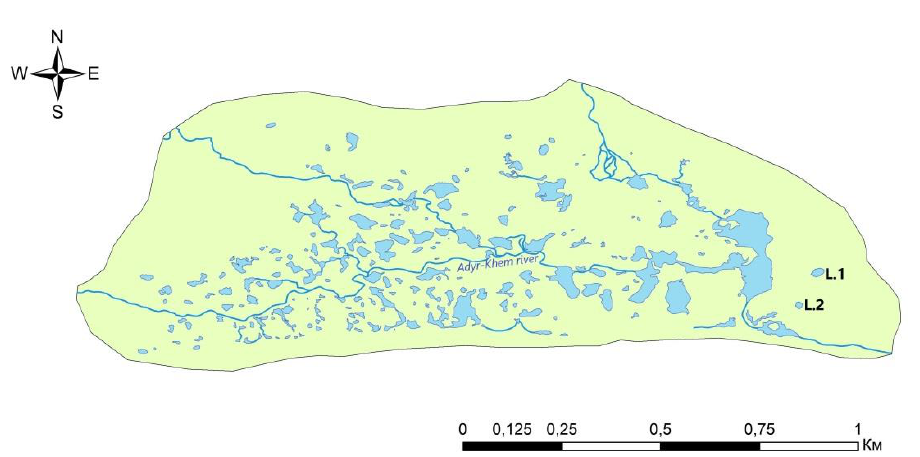
Figure 7. The open water bodies at the study site compiled for the reference date: 15 July 2021. Adyr- Khem river valley at Alash plateau; southern slope of the Western Sayan montane region, Republic of Tuva, Russia. The marks L.1 and L.2 refer to location of (untitled) thermokarst lakes studied in Section 3.3. An assessment based on interpretation of satellite imagery (Sentinel-2b, 10 m/pix resolution) along with images obtained with a drone Autel Evo ii 6k pr.